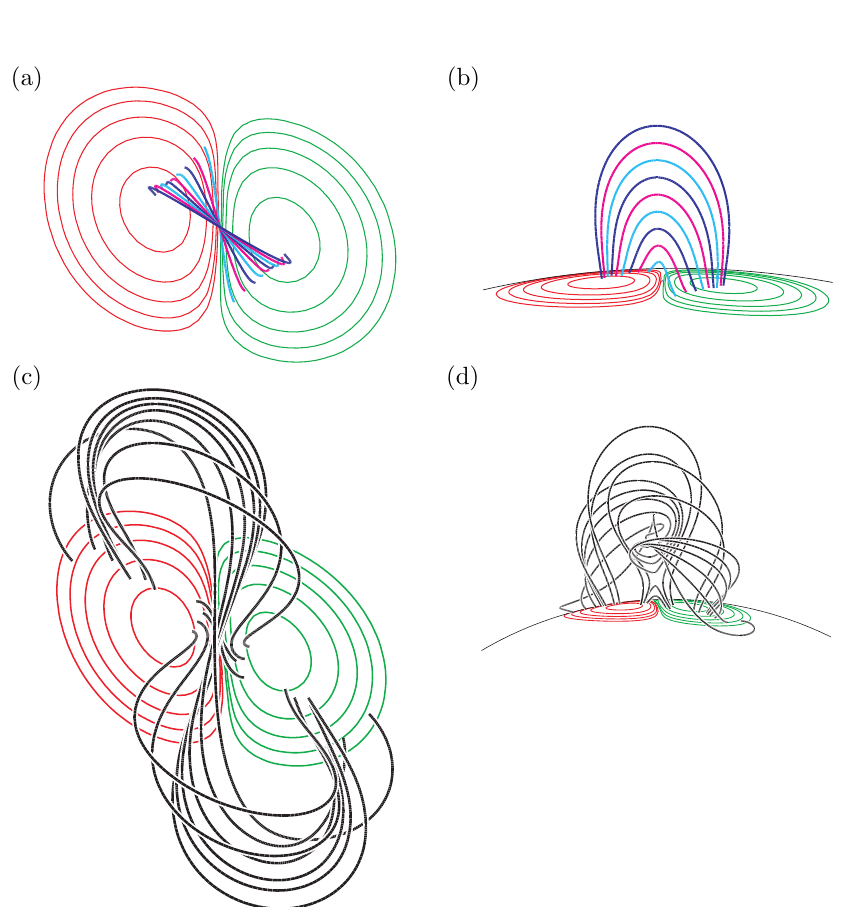
Figure 16: (a) Magnetic shear on day 10 of the simulations from above and (b) viewed from latitude –60 (cid:176) (red = positive, green = negative polarity). The shear is strongly concentrated along the PIL and at low altitude. By day 15 of the simulations, formation of sigmoidal field lines indicate strong shear (not shown). Since the submerging flux is perpendicular to the PIL (nearly potential), shear is accumulating fast in the corona along the inversion line while the flux is decreasing due to flux cancellations. On day 20, the accumulating magnetic shear leads to a loss of equilibrium resulting in a CME-like lift-off (c) as seen from latitude –60 (cid:176) and (d) from latitude +20 (cid:176) . Images reproduced with permission from van Ballegooijen and Mackay (2007), copyright by